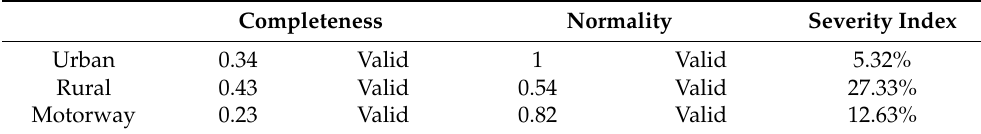
Table 3. Validity criteria required by the MAW method.